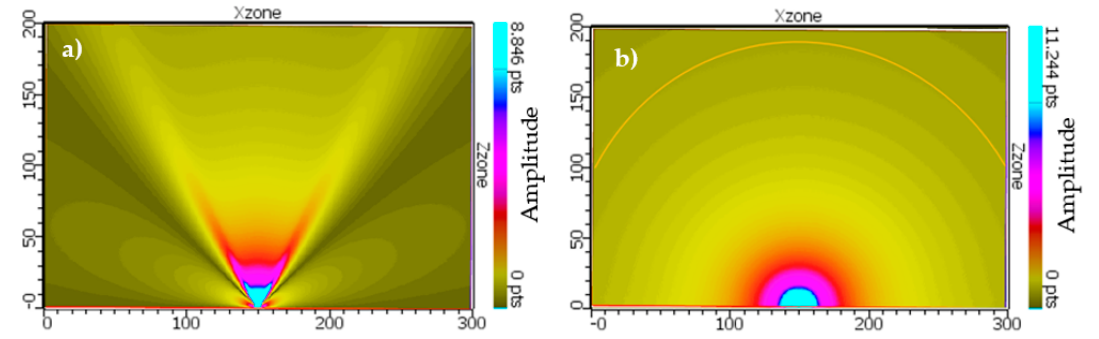
Figure 15. CIVA Simulation of point source, ( a ) radiation pattern of single shear wave probe polarization along test plane, ( b ) polarization perpendicular to test plane.